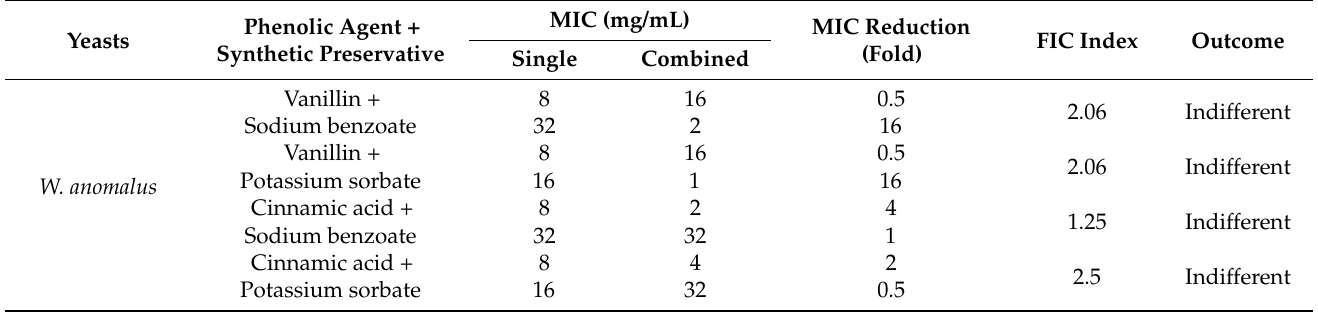
Figure 2. Effect of the antimicrobial agents on the planktonic growth of D. hansenii SZMC 8045Mo ( A ), W. anomalus SZMC 8061Mo ( B ), S. pombe SZMC 1280 ( C ), and S. cerevisiae SZMC 1279 ( D ) when the cinnamic acid and synthetic agents were used alone or in combination in equal proportions. The control (Cont.) represents growth in the absence of the compounds. The results are the mean percent growth relative to the control; error bars represent standard deviation. The different letters above the columns indicate statistically significant differences ( p < 0.05). Table 4. Effect of combination of phenolic compounds and synthetic preservatives on biofilm formation of food spoilage